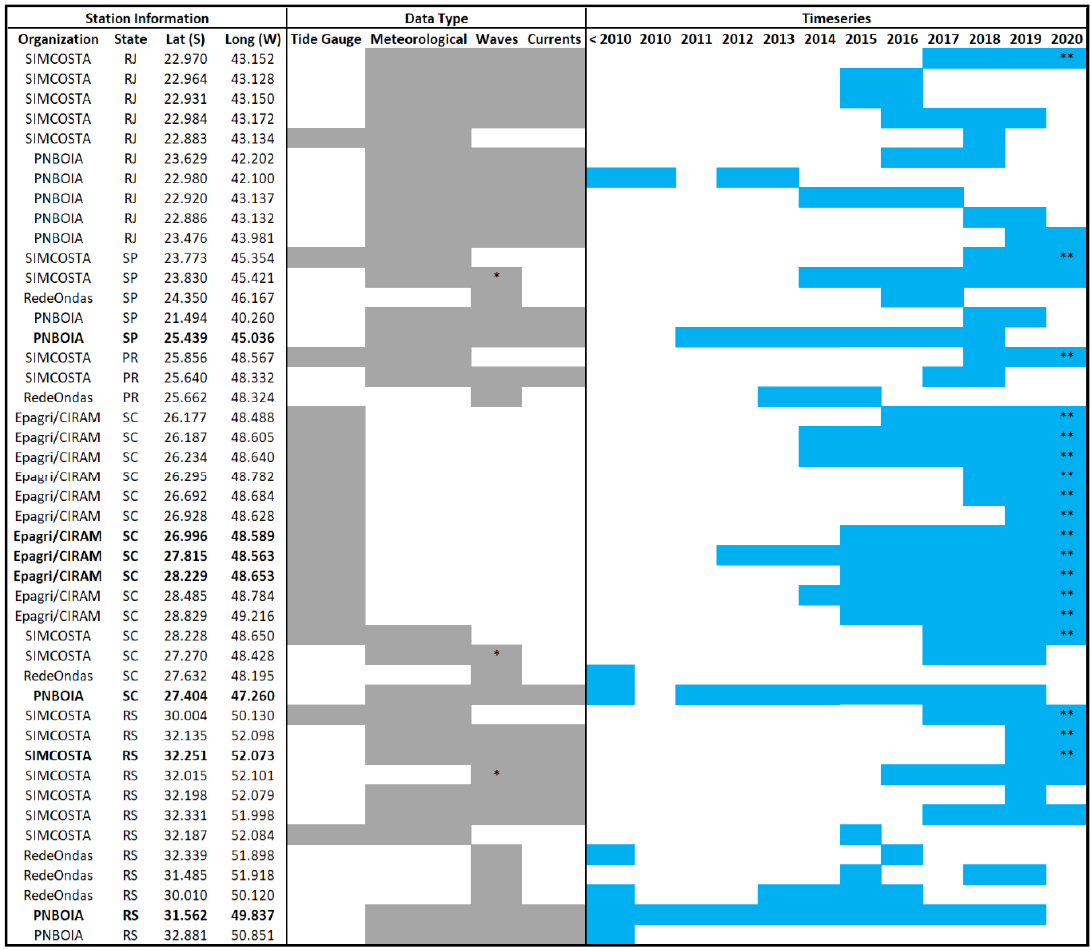
Figure 2. Available meteo-oceanographic observational data in the study area. Selected stations for model validation are presented in boldface and shown in Figure 1. * No wave data ** Real-Time.